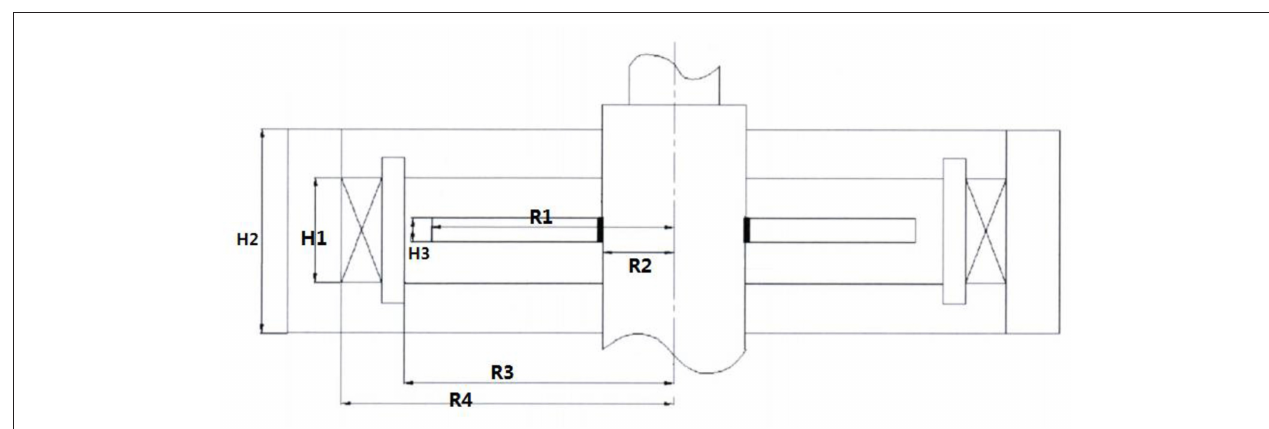
FIGURE 2 | Structure parameters diagram of the MR